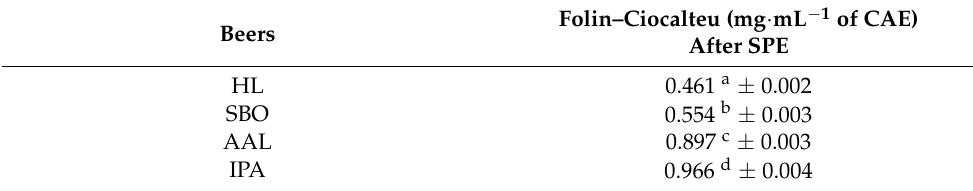
IPA 0.966 d ± 0.004 Values are means of three measurements ± standard error of the mean (SEM). Values are presented by means of mg chlorogenic acid equivalents (CAE) per mL of beer. Values with different superscripts (a, b, c, and d) are statistically different at p < 0.001.